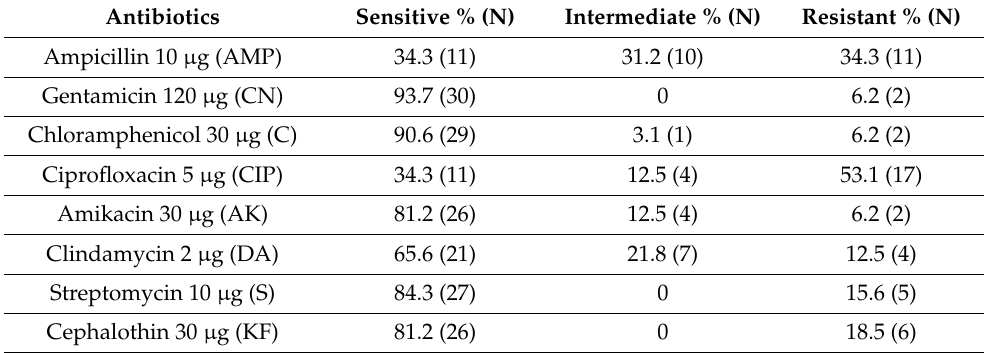
Table 1. Antibiogram of S. aureus clinical isolates. Eight regularly prescribed antibiotics were tested against S. aureus isolates for antibiotic